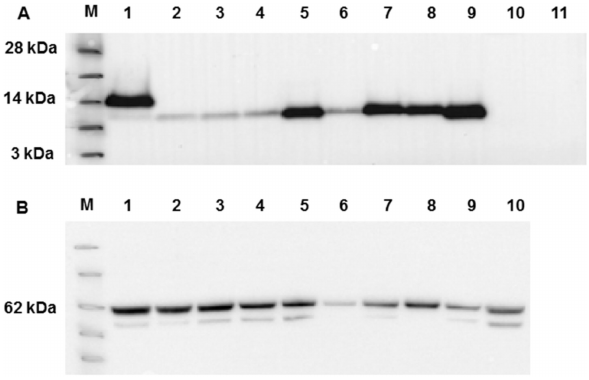
Figure 4. Western blot analysis of WT MHV-E protein expression and mutants following expression in insect cells. ( A ) Western blot using anti-His antibody. Lane M - See Blue ™ Plus2 Pre-Stained